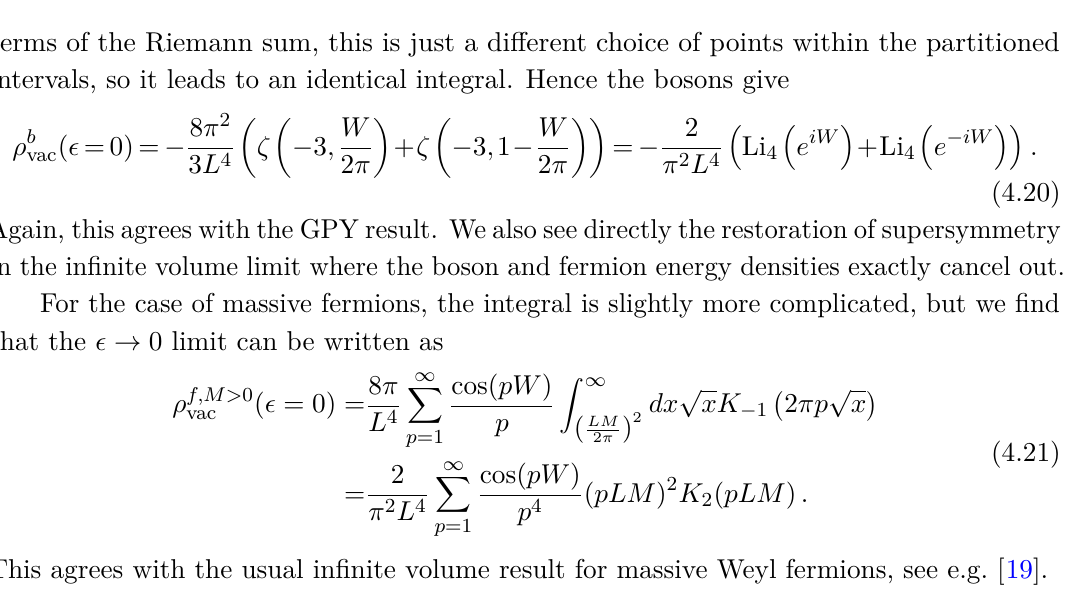
Figure 2 . The purely bosonic contribution to the GPY potential. The numerical evaluation used N n = 100000 and N p = 500 as the upper limit for the n - and p -sums in equation (4.13). The upper limit for the Taylor series in equation (4.17) was taken to be N = 500 . The numerical reliability m breaks down near the boundary of the region without a tachyon, so the plot only covers the values hq q i in the interval, . The value diverges down to negative infinity as W approaches 2 π(cid:15) 2 π(cid:15) , 2 π − 0 . 99 0 . 99 √ √ the values W = 2 π(cid:15) and W = 2 π − 2 π(cid:15) . The infinite volume limit follows from equation